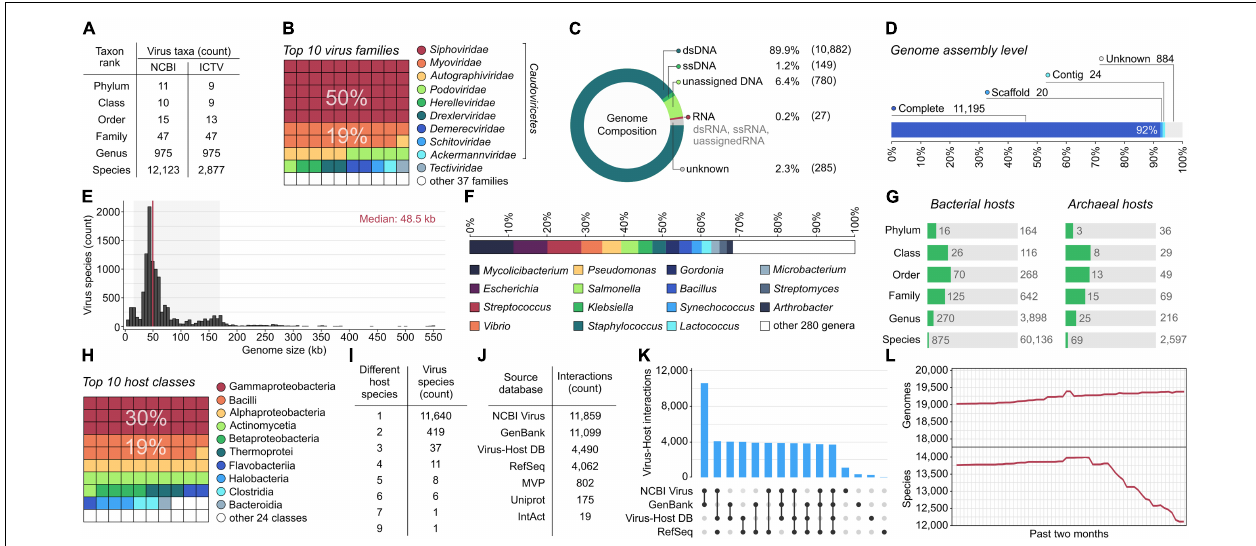
FIGURE 1 | Genomic and taxonomic diversity of prokaryotic viruses and their hosts (as of May 1, 2022). (A) Number of different virus taxonomic units across six taxonomic ranks (from species to phylum) according to National Center for Biotechnology Information (NCBI) Taxonomy and the International Committee on Taxonomy of Viruses (ICTV). (B) Ten most abundant virus families represented by the highest number of virus species. (C,D) The number of representative viral genomes stratified by genome composition and assembly level. (E) Size distribution of completely sequenced virus genomes. The red vertical line indicates the median genome size, and the light gray background represents the range between the 5 th and 95 th percentiles. (F) Proportion of viruses isolated on the top 15 most abundant host genera (i.e., host genera infected by the highest number of viruses). (G) Number of different taxonomic units of bacterial and archaeal hosts across seven taxonomic ranks compared to the number of all bacterial and archaeal taxa present in NCBI Assembly. (H) Ten most abundant host classes represented by the highest number of known host species. (I) Number of virus species isolated on a different number of host species. (J) Comparison of the number of pairwise interactions between virus and host species in different databases. (K) Unique and shared virus-host interactions among four databases. The bar chart indicates the intersection size of virus-host interactions. Connected black dots on the bottom panel indicate which combination of the databases was considered for each intersection. Single, unconnected black dots represent virus-host interactions unique to each database (L) Number of genomes and virus species reported daily in the last 2 months (from March 1 to May 1, 2022). Virus genomes were assigned to species based on the then-most-recent NCBI